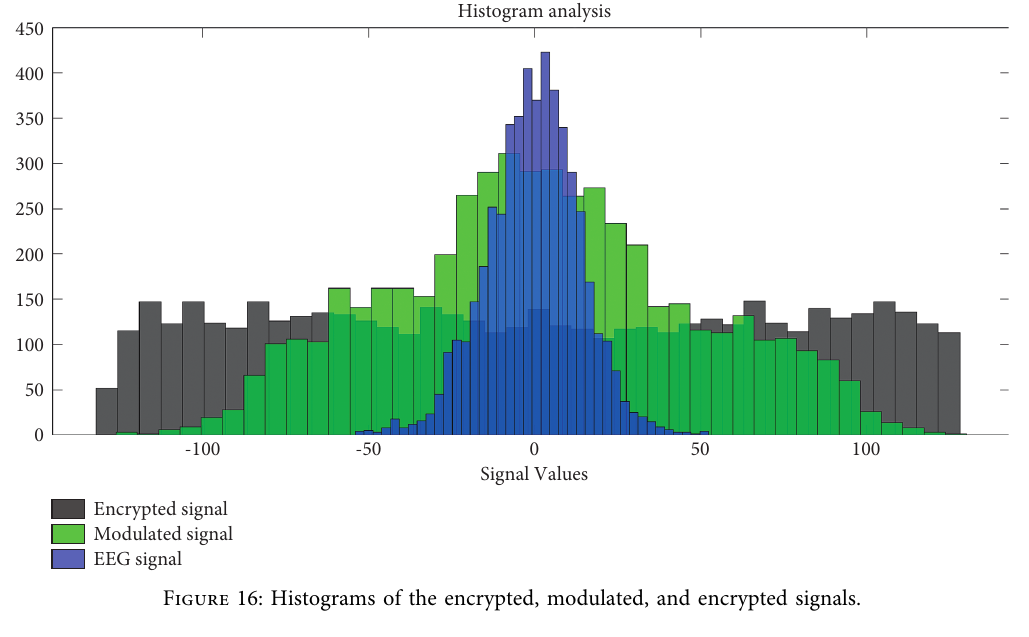
Figure 16: Histograms of the encrypted, modulated, and encrypted